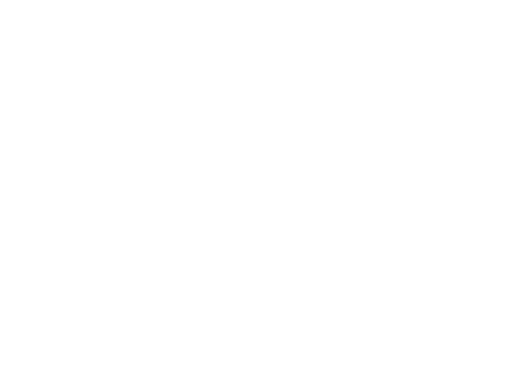
Table 4. Pearson correlation analysis. * p < 0.05, ** p < 0.01, *** p < 0.001.